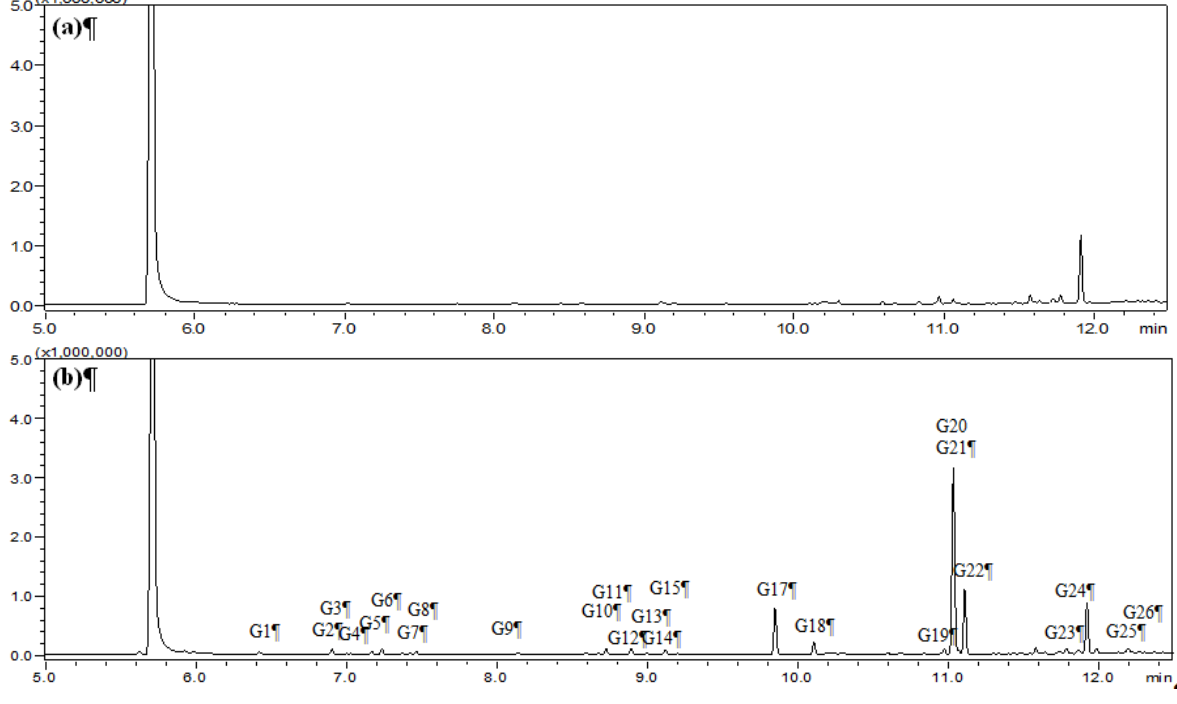
Figure 3. Total ion chromatograms of plasma obtained from ( a ) blank group and ( c ) Asari Radix et Rhizoma (AR) powder group using